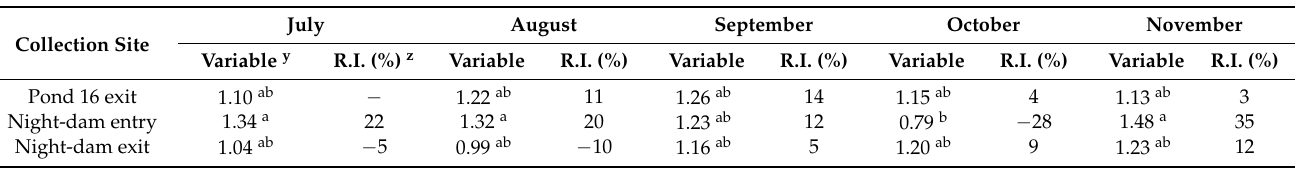
Figure 4. Log-transformed mean counts of Vibrio fluvaris , Vibrio parahaemolytica , Vibrio cholerae , and Vibrio aginolytica as affected by collection site along the wastewater treatment pathway from Pond 16 exit to night-dam exit relative to those in the borehole water. Table 3. Log transformed Ascaris lumbricoides counts as distributed along the wastewater treatment pathway from Pond 16 exit to night-dam exit for five months in 2019.